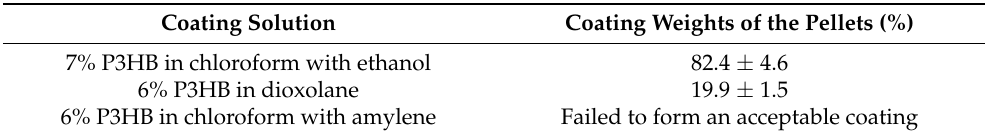
Table 4. Average coating weights (in%) and standard deviation of the weight of the original pellets (n = 10) after applying six layers of